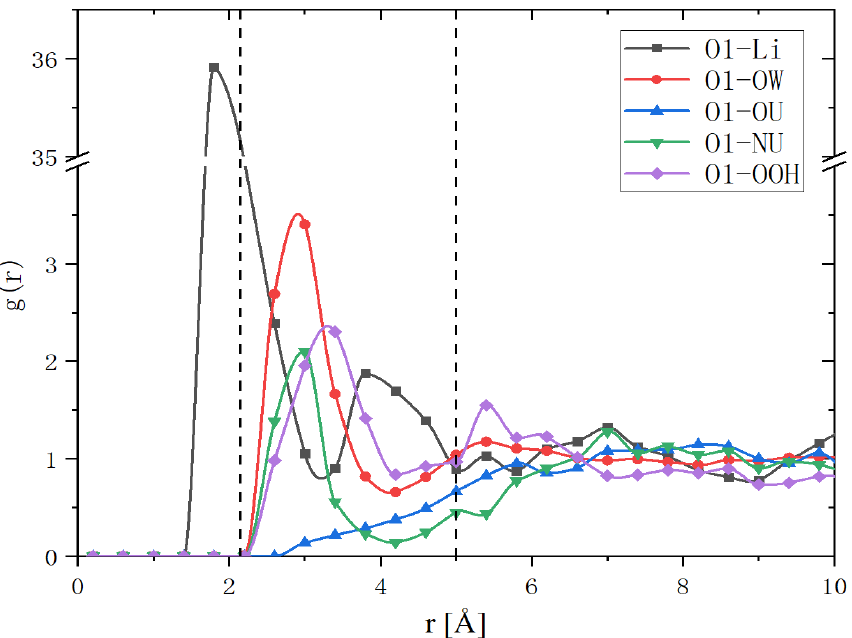
Figure 6. RDF distributions of Li, OW, OU, NU and OOH around O1 atom along Z -axis. The dashed lines are used to indicate the boundary of the second hydration layer.